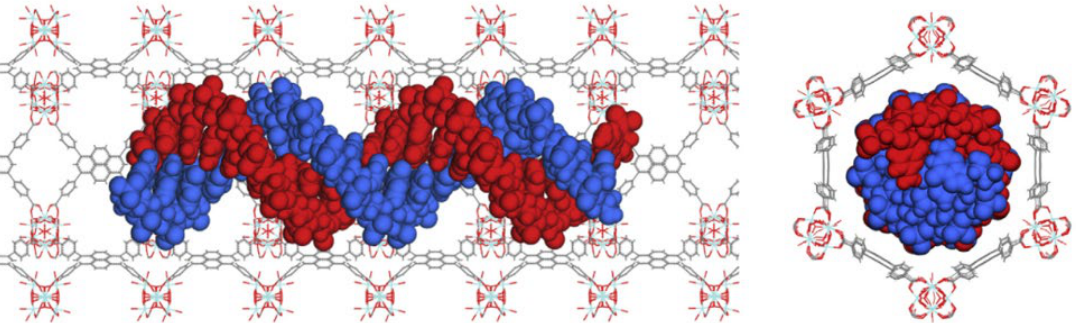
Figure 12. Schematic of one double-stranded siRNA molecule in NU-1000 pore [185]. Adapted from ref. [185] with